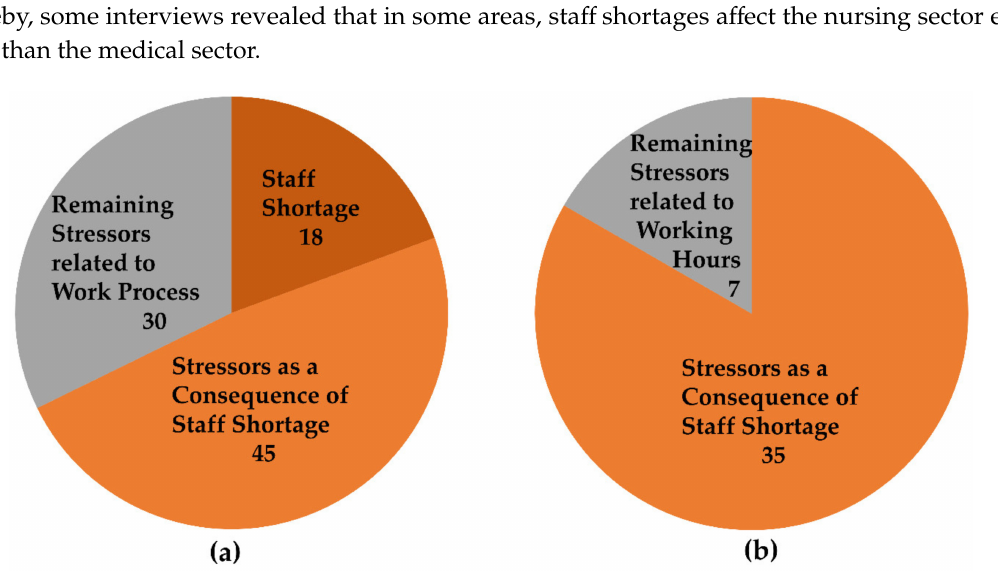
Figure 3. Graphical representation of ( a ) stressors related to the work process divided into the subcategory sta ff shortage, stressors as a consequence of sta ff shortage, and remaining stressors